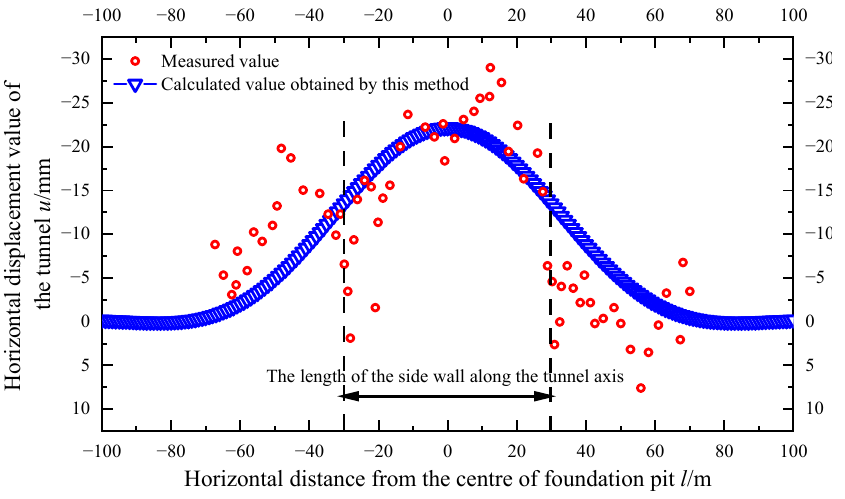
Figure 14. Comparison of the calculated and measured values of the horizontal displacement of the tunnel beside the foundation pit in case 5.